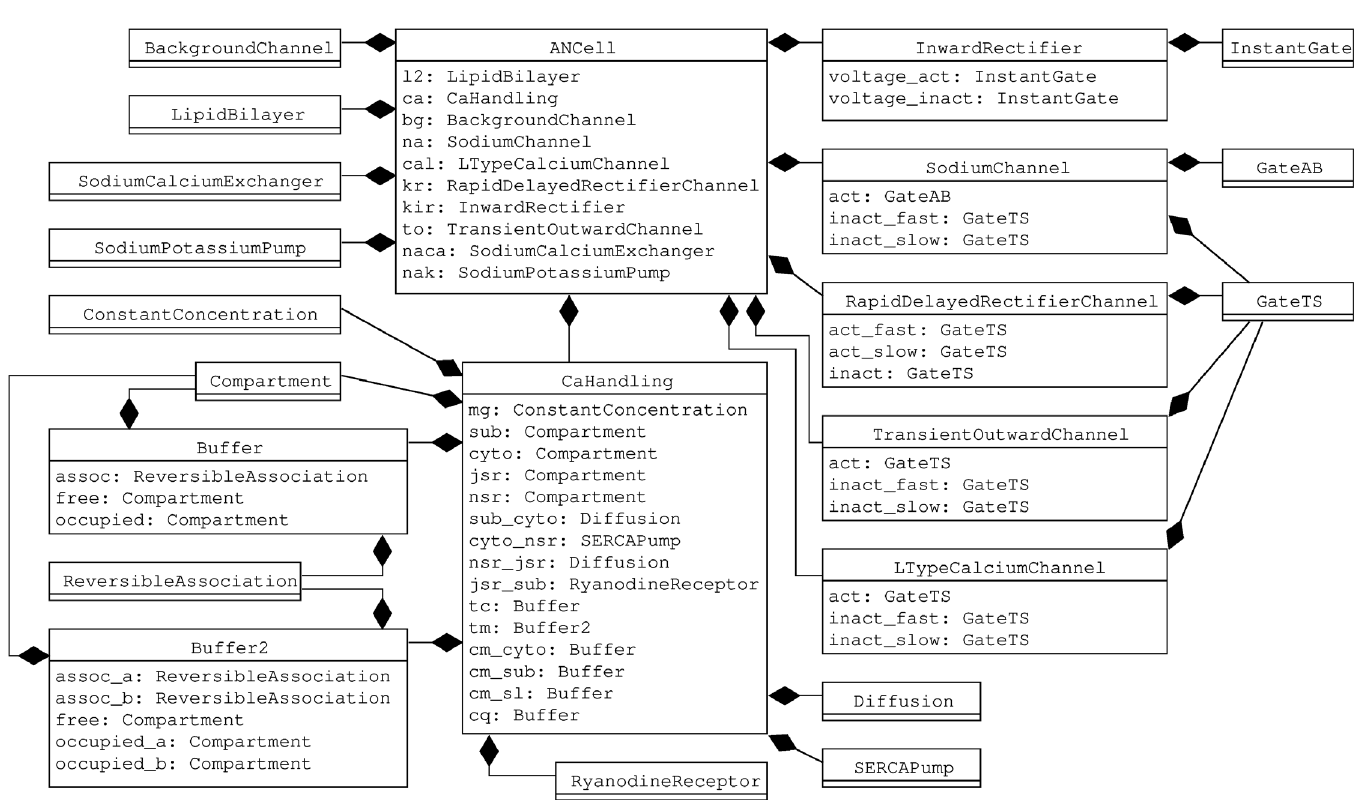
Fig 2. Hierarchical composition of AN cell model in InaMo version 1.4.1 as UML diagram. The composition arrow indicates that the model at the beginning of the line is a part of the model at the end of the line, where the diamond shape is located.